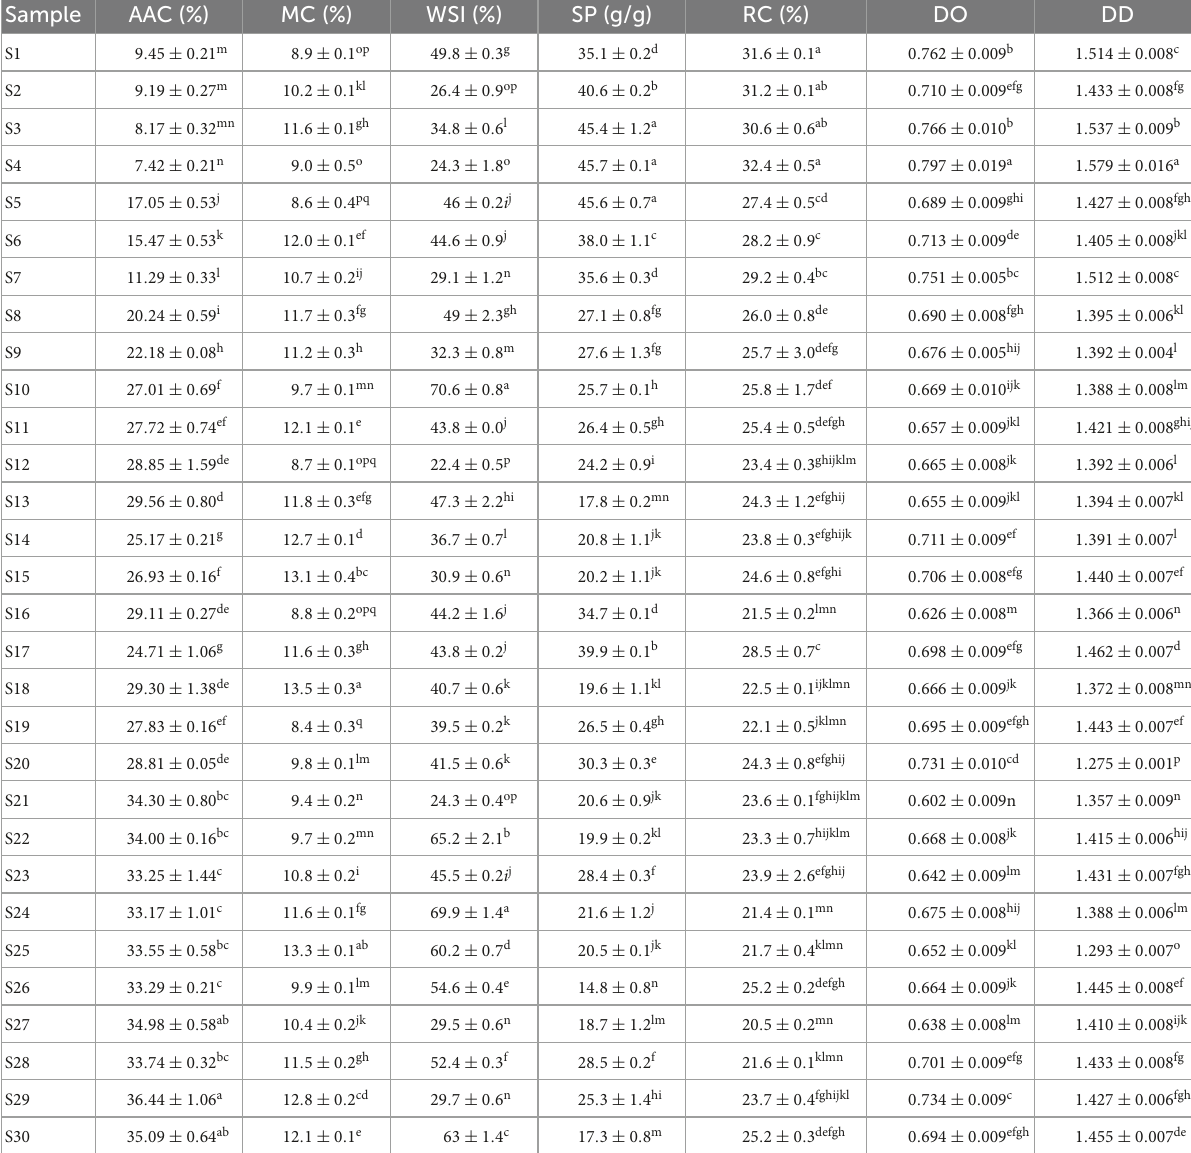
TABLE 2 Apparent amylose content, moisture content, water solubility index, swelling power, relative crystallinity, degree of order, and degree of double helix of sorghum